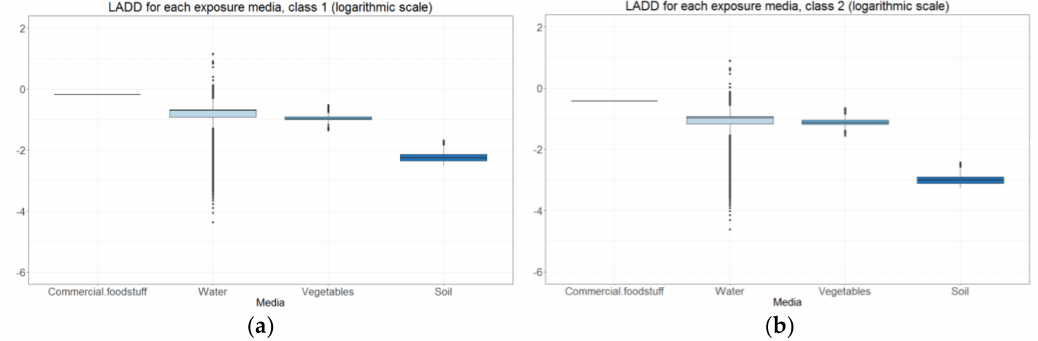
Figure 10. Lifetime Average Daily Doses (LADD) by exposure media for France, measured in